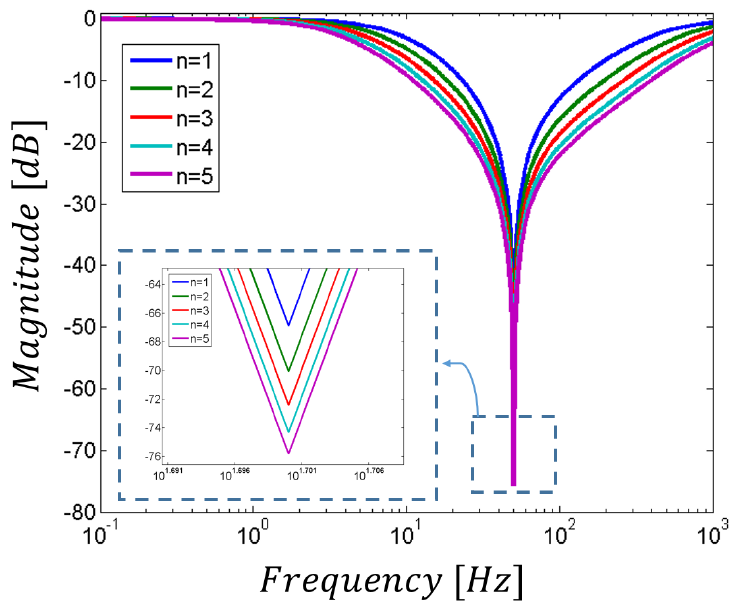
Figure 7. Modified notch filter transfer function and its dependence on n .